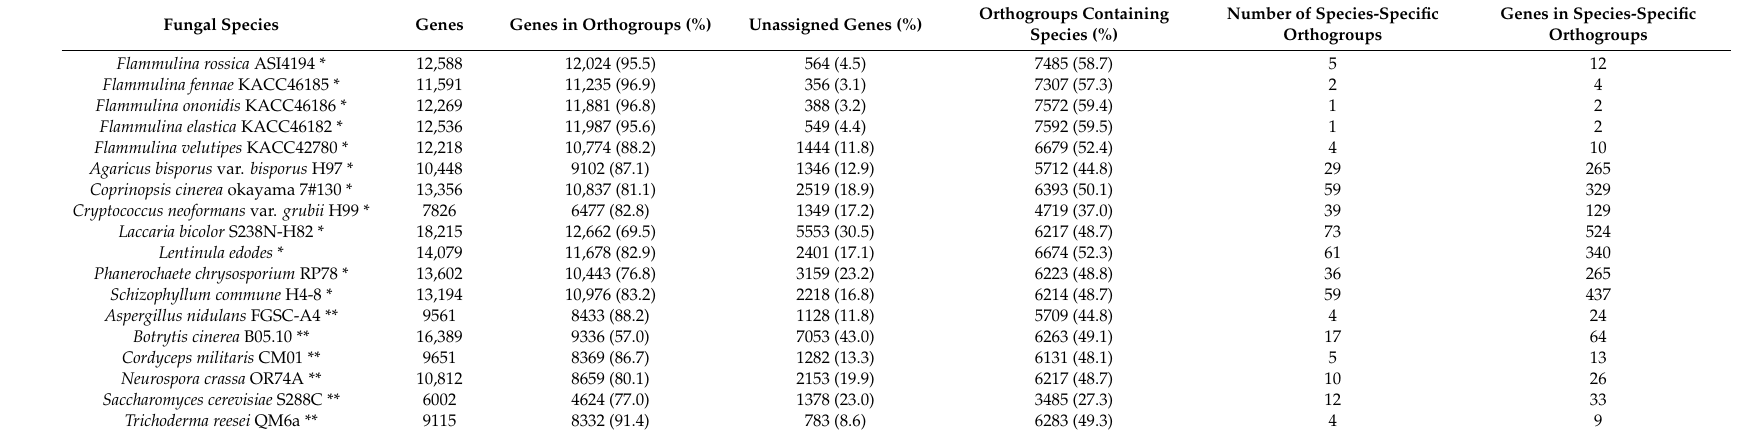
Table 3. Ortholog analysis of Flammulina rossica and other fungal